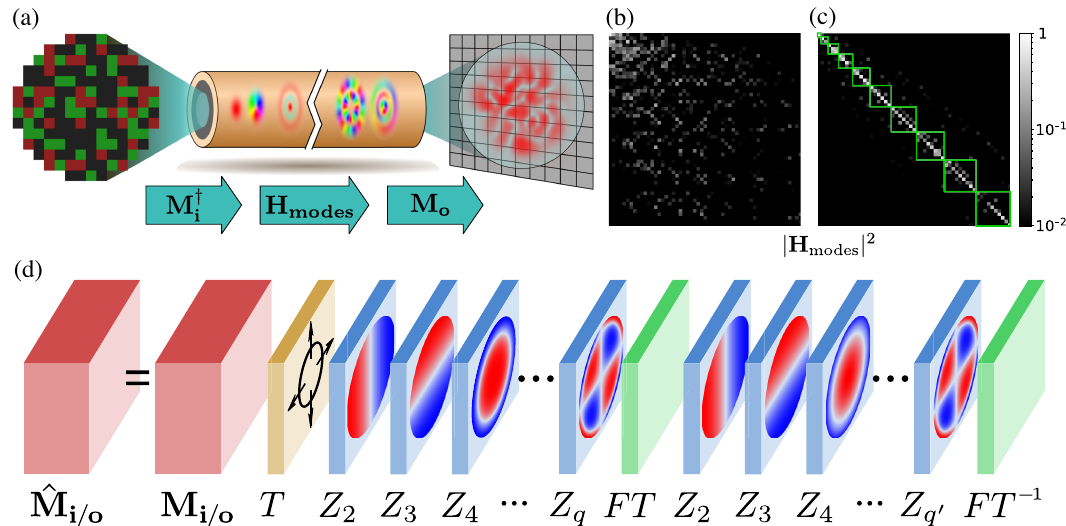
FIG. 1. Principle of the MMF TM reconstruction in the mode basis with the automatic compensation of the aberrations. (a) Simplified sketch of the experiment: The input wave front is modulated using a spatial light modulator and sent on the input facet of an MMF. The light is transmitted through the propagating modes, and the complex output field is imaged onto a camera. The TM is measured in the pixel basis and numerically projected onto the theoretical propagating modes. M i and M o represent to the input and output change of basis matrices, respectively, and H is the TM in the mode basis. (b),(c) Intensity of the experimentally measured TMs in the mode modes basis before and after the numerical compensation of the aberrations for one input and one output polarization. The green squares represent the groups of degenerate modes. The complete TMs are presented in Supplemental Material [30] Sec. S2. (d) Schematic of the model architecture used for the compensation of the aberrations. M i and M o are modified by differentiable and trainable layers representing a homothety (yellow layer) and phase aberrations characterized by Zernike phase polynomials (blue layers). The Fourier transforms (green layers) allow applying aberrations in the direct and the Fourier planes. The models for the two input and output mode conversions are trained simultaneously against a merit function that maximizes the energy in the projected matrix H (see modes Appendix